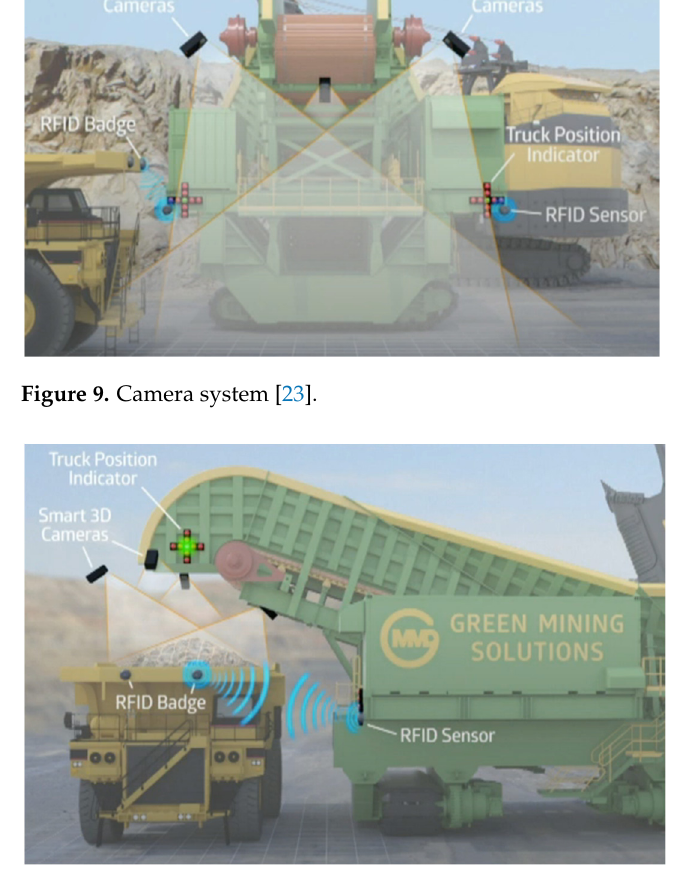
Figure 11. Truck routes with the surge loader [23].